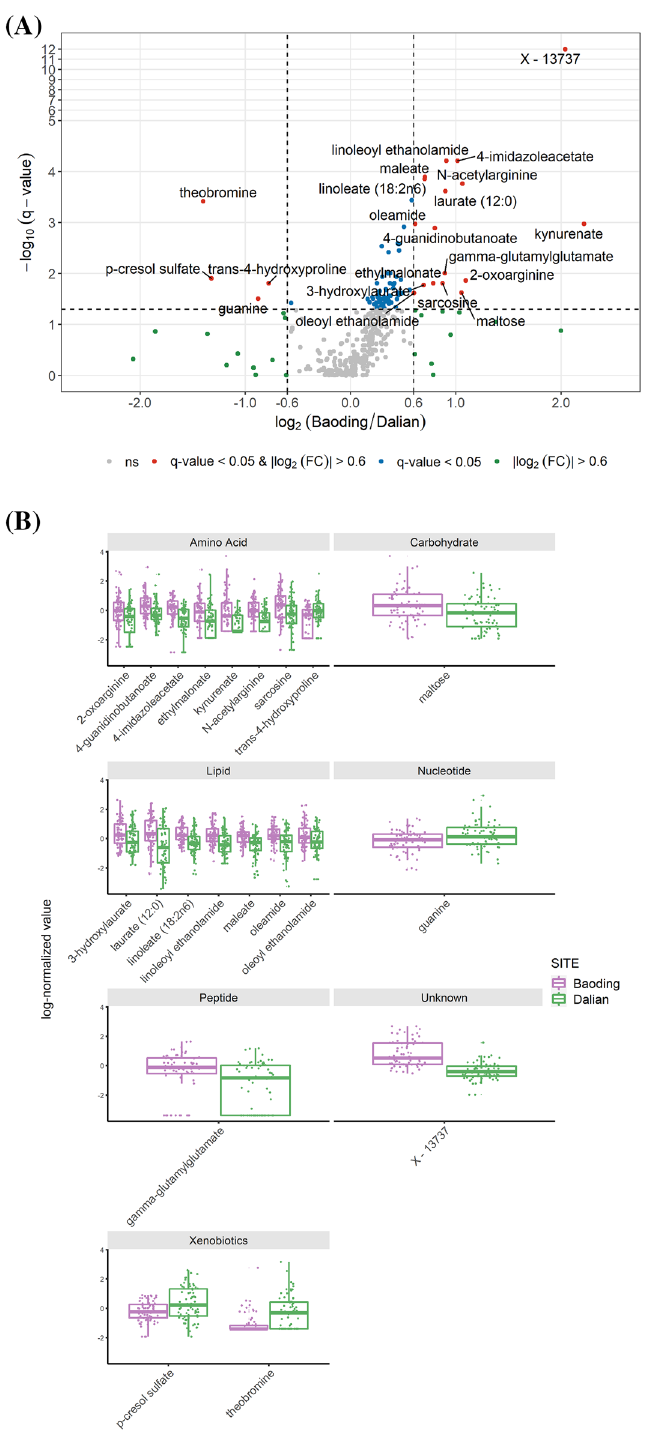
Figure 3. ( A ) Volcano plot representing the log2(FC) in x-axis and -log10(q − value) in y-axis. A threshold of 0.6 for the log2(FC) is added as a dotted vertical black line and a threshold of − log 10 (0.05) as a dotted horizontal black line for the q-value. For representation purpose, the y-axis scale has been squashed by a factor of 5 between 5 and 12. A metabolite is considered significantly modulated if its |log 2 (FC)|> 0.6 and q-value < 0.05 (in red and labelled on the figure). ( B ) Boxplots of significantly modulated metabolites, gathered by pathway, Baoding (More Polluted) and Dalian (Less Polluted). Figures were created using the R software: R Core Team (2017), R Foundation for Statistical Computing, Vienna, Austria. URL https:// www.R- proje ct.